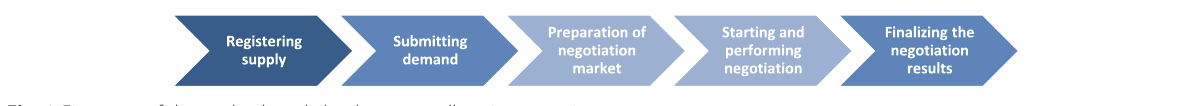
Fig. 2 Five steps of the market-based cloud resource allocation